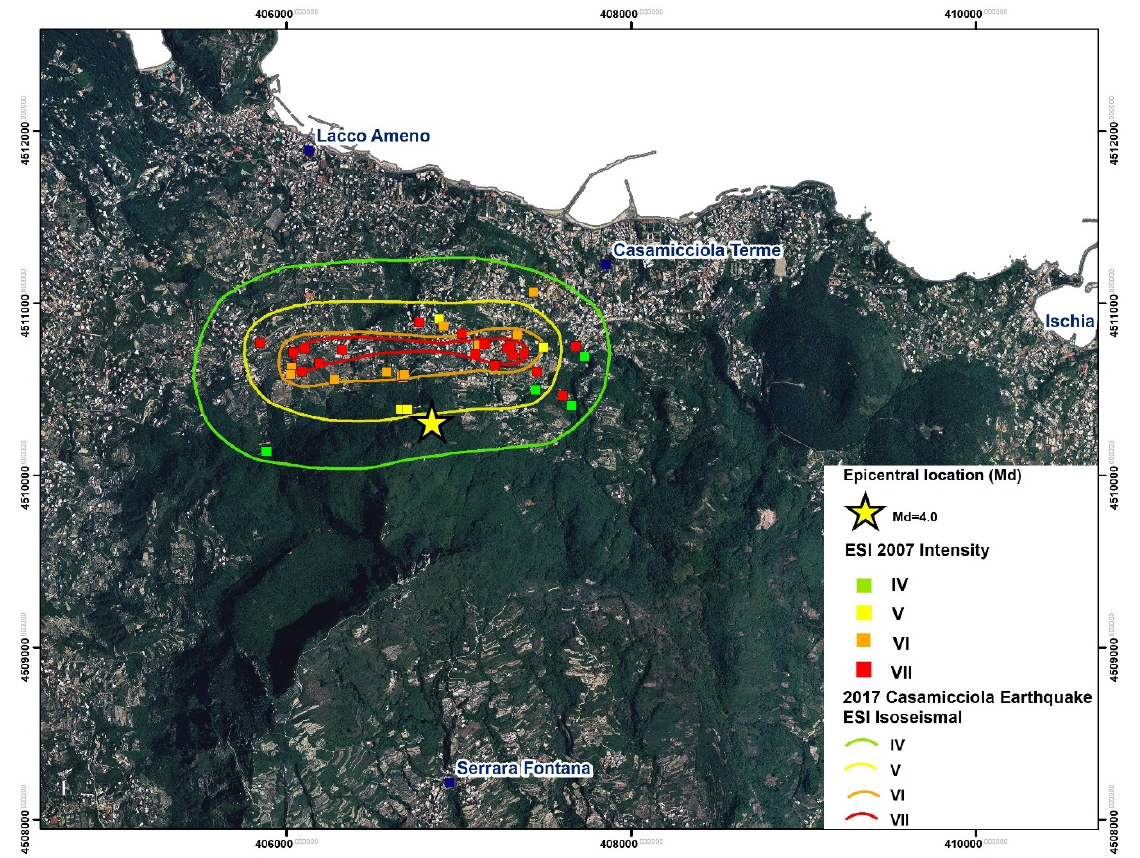
Figure 5. Isoseismals of the 21 August 2017, Casamicciola earthquake according to the ESI 2007 scale; the sites with environmental effects are described in the sheets available in the Table S1.